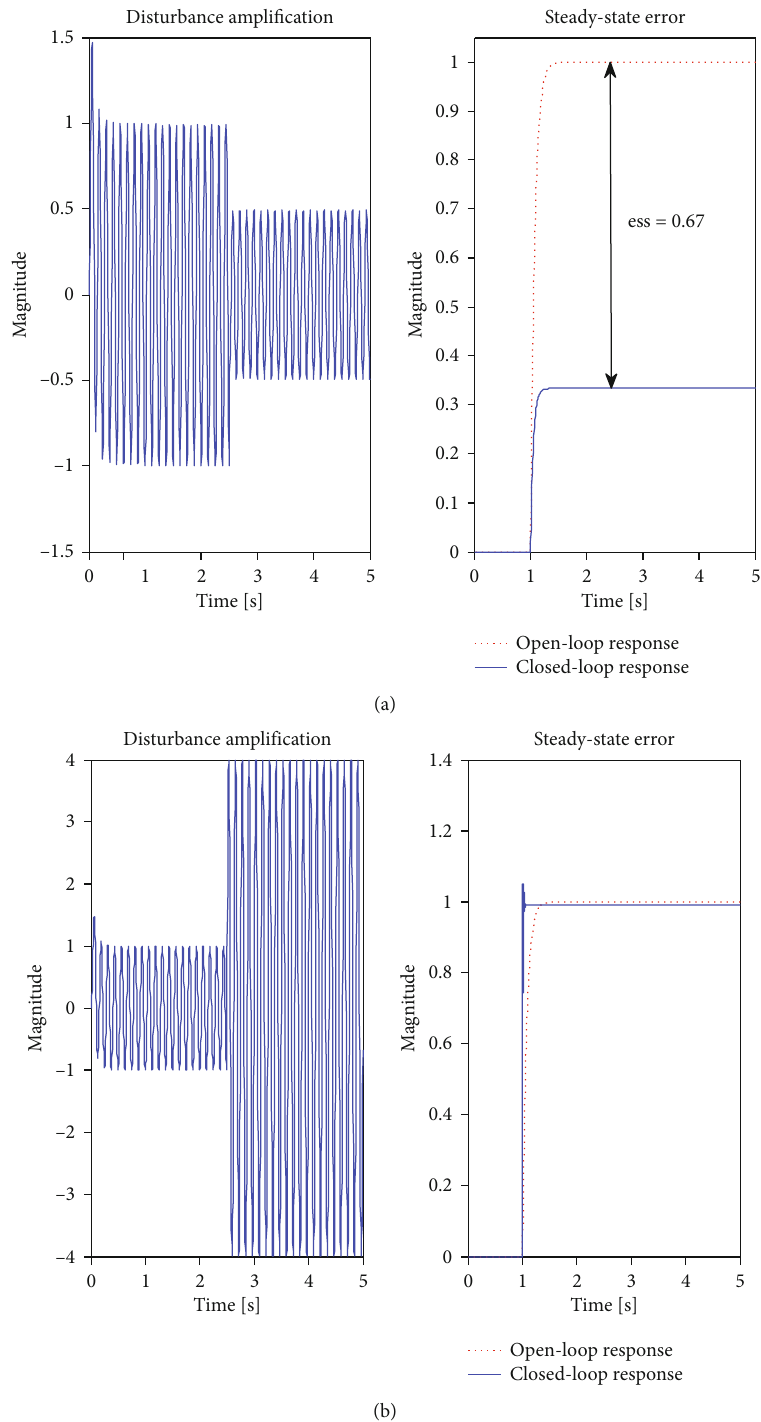
Figure 3: Compromise between disturbance transmission performance and steady-state performance, illustrating clearly that high-gain control design philosophy should be challenged in aeroengine control